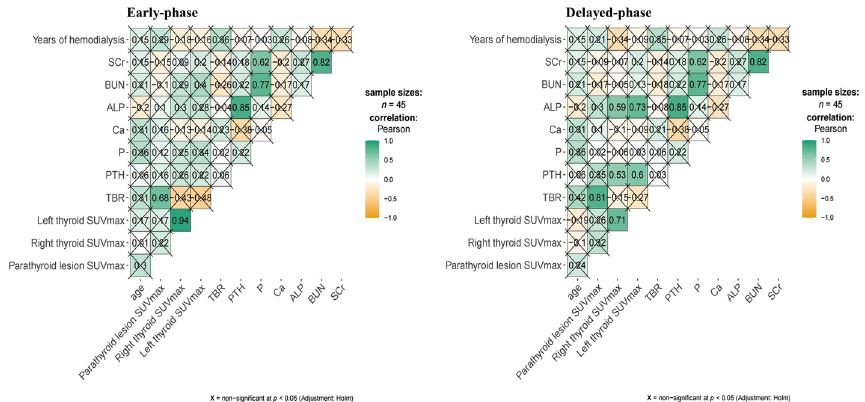
Fig. 5 Correlations of TBR and SUVmax with serum biochemistry. The only factor significantly associated with TBR was parathyroid lesion SUVmax. The correlation tests between other factors and TBR showed no statistical